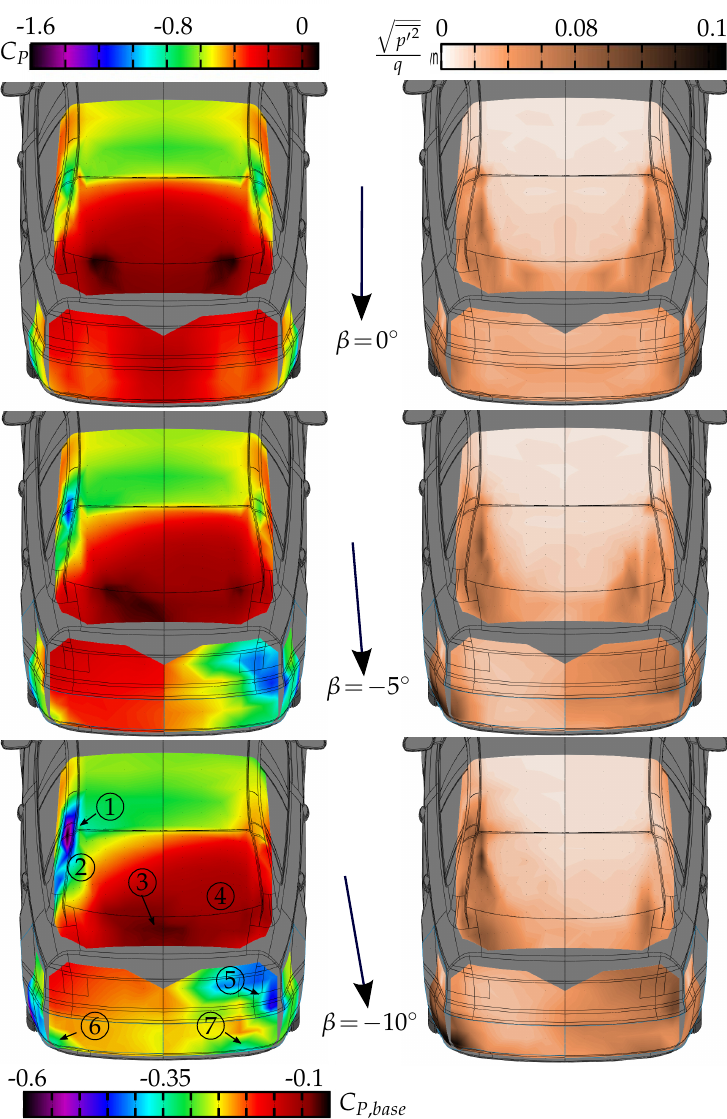
Figure 2. Surface pressure ( left ) and pressure fluctuation ( right ) at various side wind